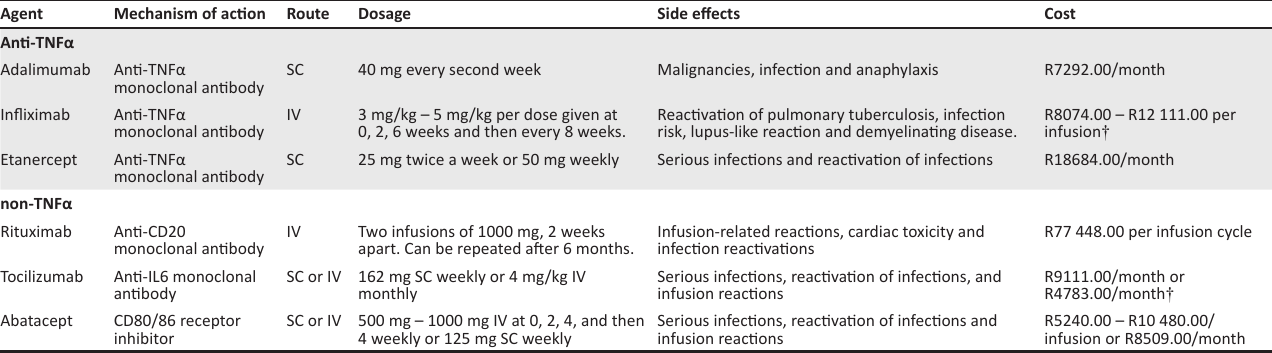
TABLE 3: Biological agents for the management of autoimmune peripheral ulcerative keratitis.